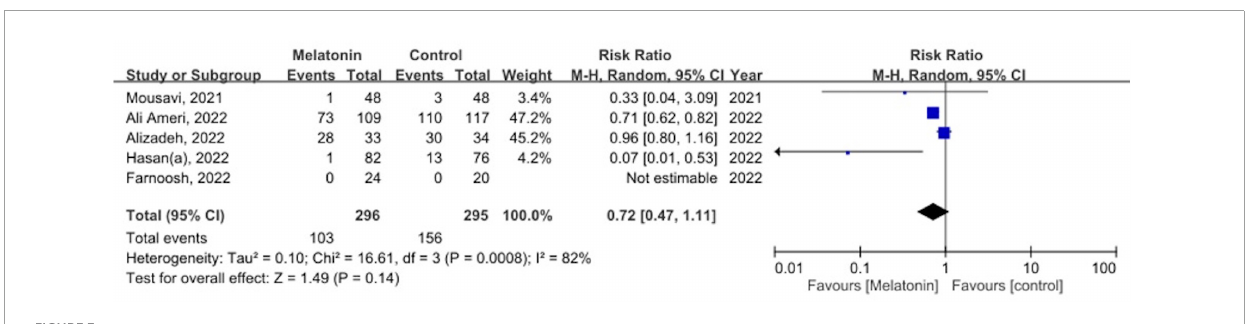
FIGURE3 The forest plot depicts the mortality by comparing the melatonin group versus control